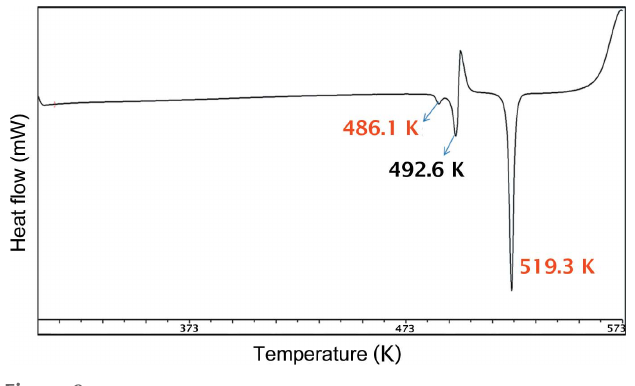
Figure 9 DSC thermogram of Compound-B Form I.